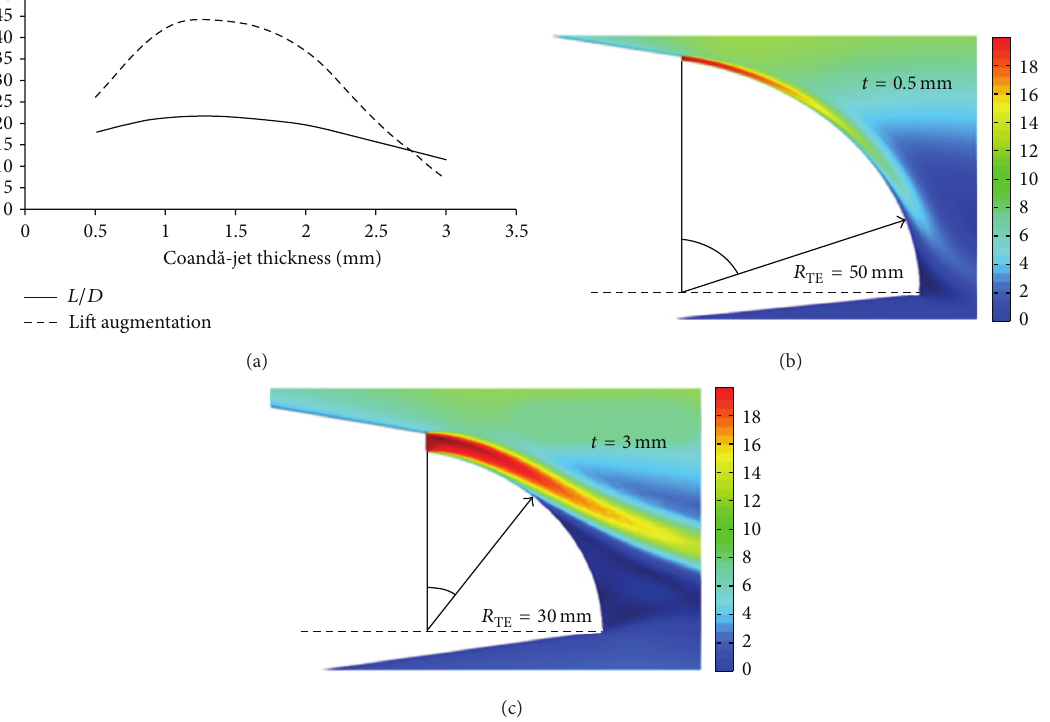
= 30mm); (b) flow separation with t = 0.5 mm; TE